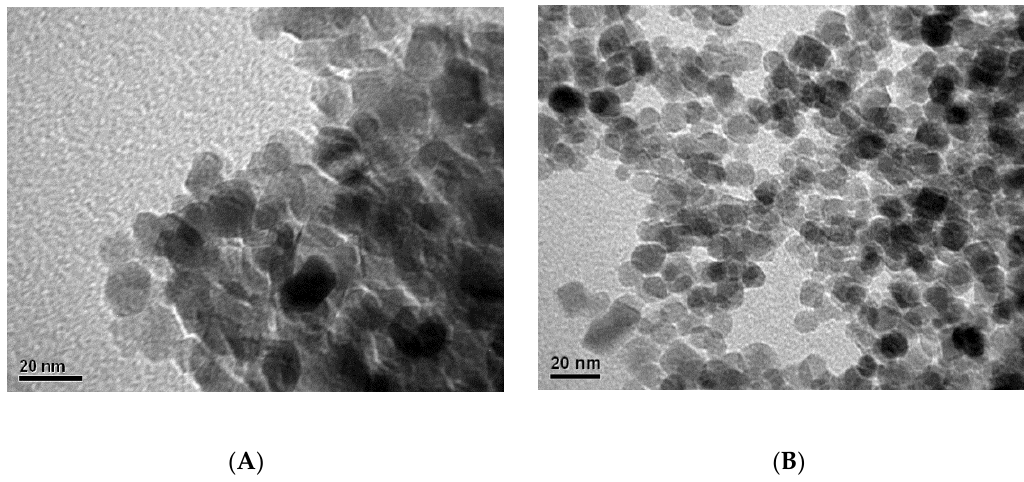
Figure 4. Transmission electron microscopy (TEM) images of ( A ) material (MT1) and ( B ) MT2.